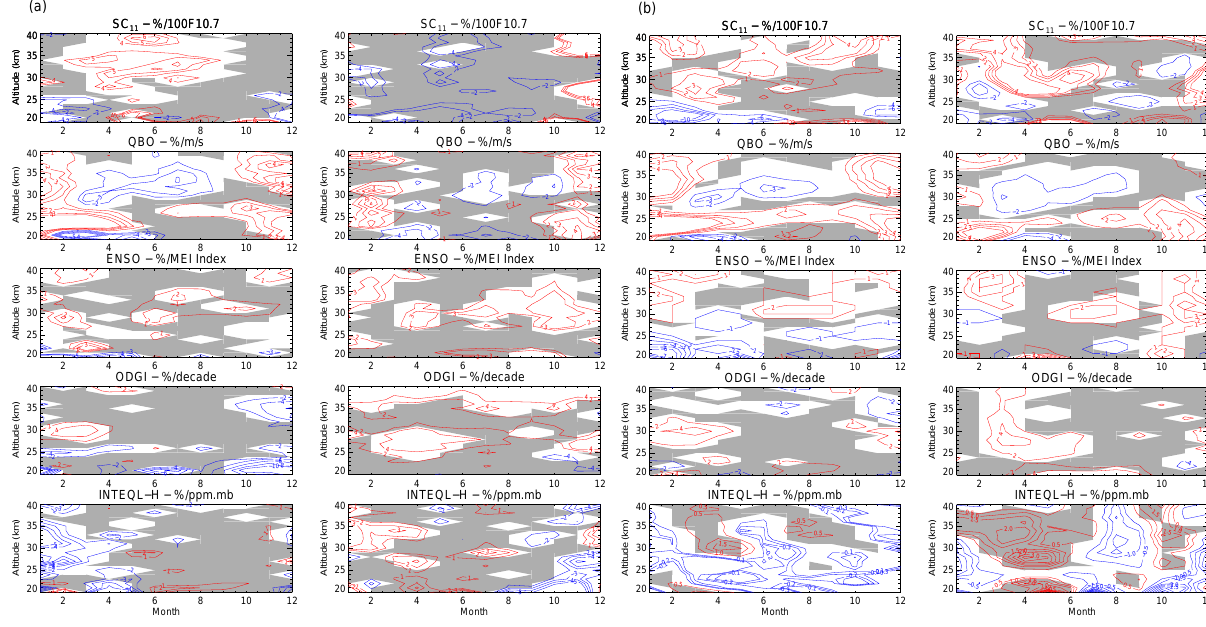
Fig. 6. Seasonally dependent response to the most influent proxies as calculated by the regression analysis with lidar (a) and merged satellite (b) time series. MLO results are on the left and TMF on the right-hand side. The shaded regions indicate that the results are not significant at the 2 σ confidence level, the blue dash contour lines denote the negative values and the red solid contour lines denote positive values.